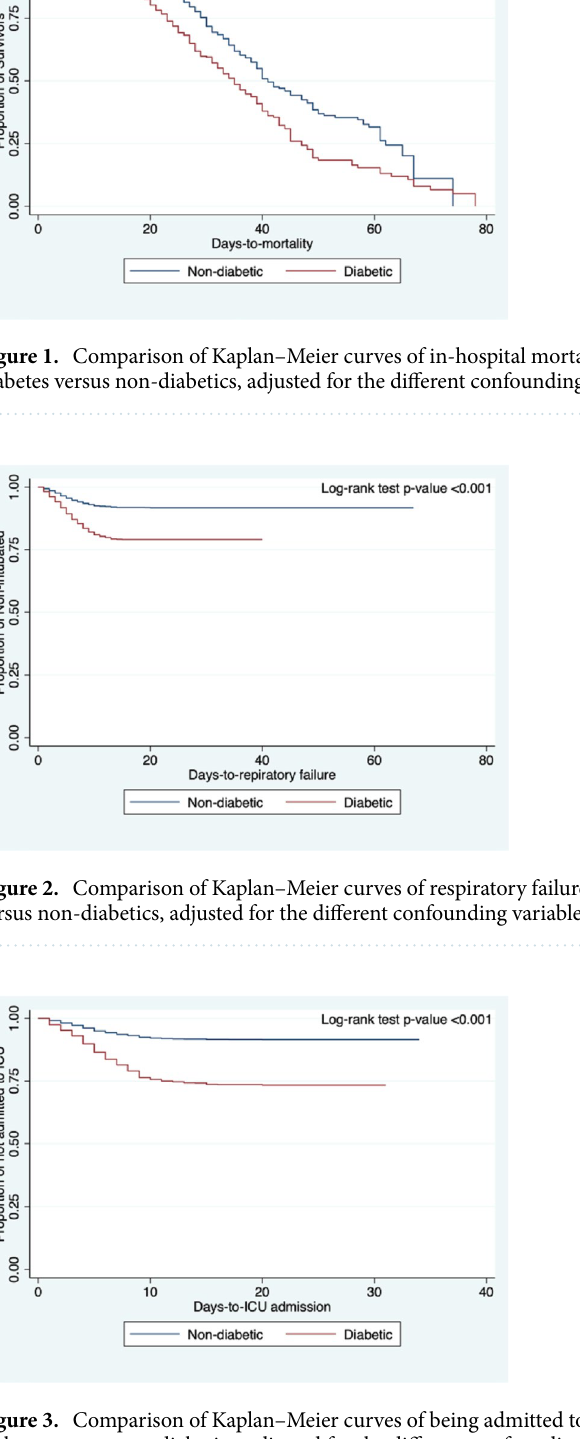
Figure 3. Comparison of Kaplan–Meier curves of being admitted to ICU between COVID-19 patients with diabetes versus non-diabetics, adjusted for the different confounding variables of